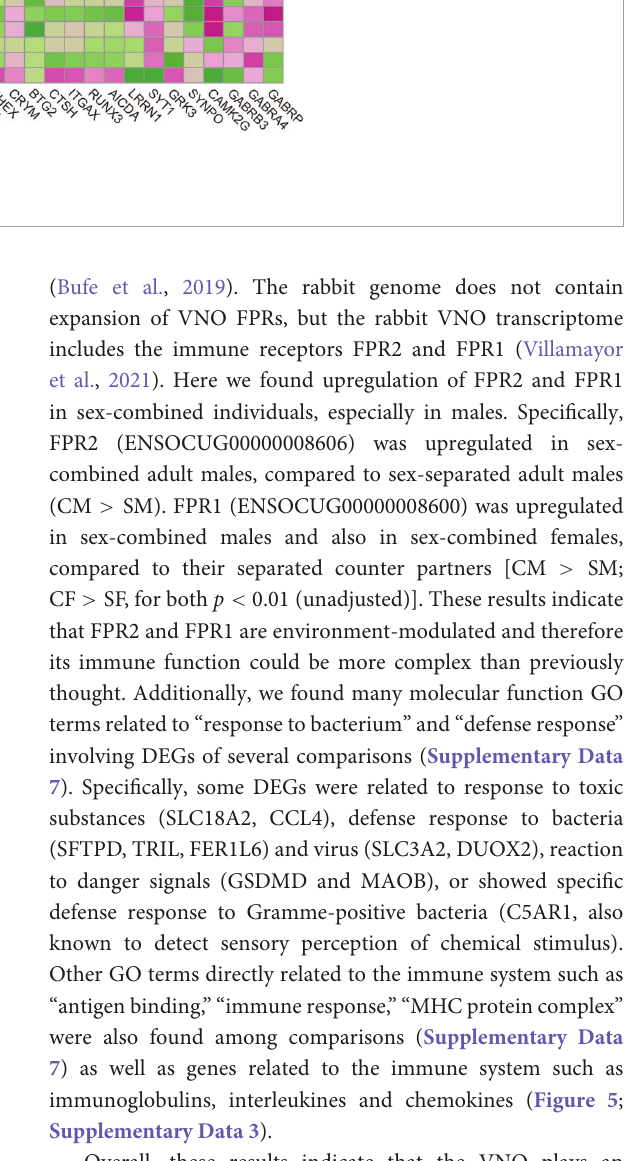
FIGURE4 Heatmap of genes related to the VNO functional activity.